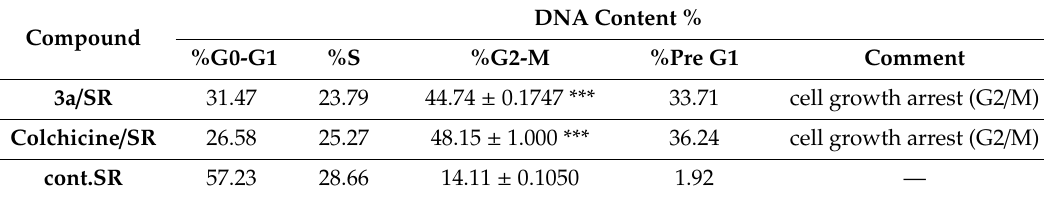
Table 5. DNA content % using propidium iodide flow cytometry.